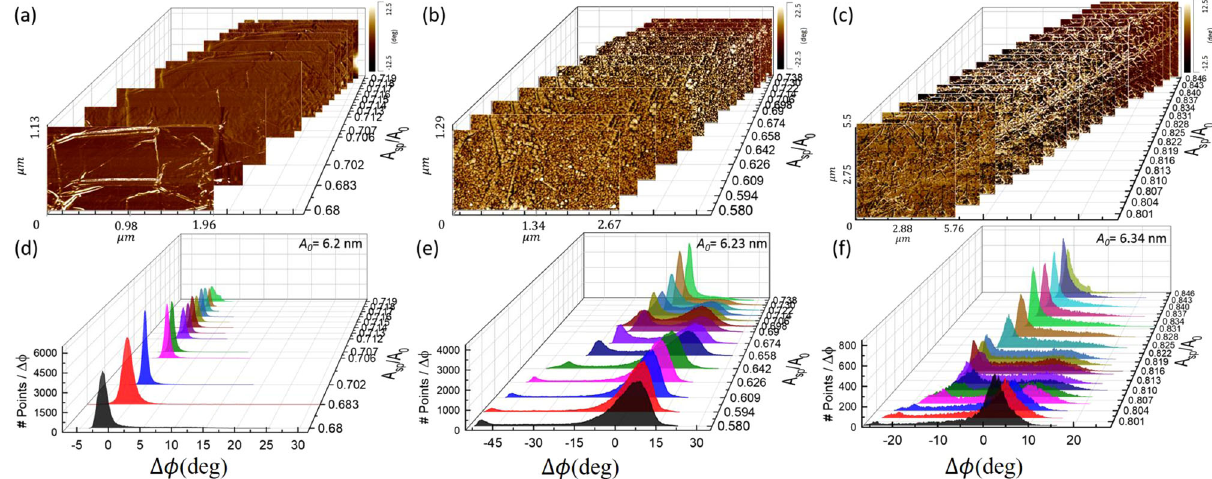
Fig. 2 3D Stacked phase images and their corresponding histogram distributions obtained for varying amplitude setpoints A sp . a , d mGO; b , e DxO@mGO; c , f MxD@mGO. Experimental free amplitude A 0 for mGO is 6.2 nm while that for DxO@mGO is 6.32 and 6.34 nm in the case of